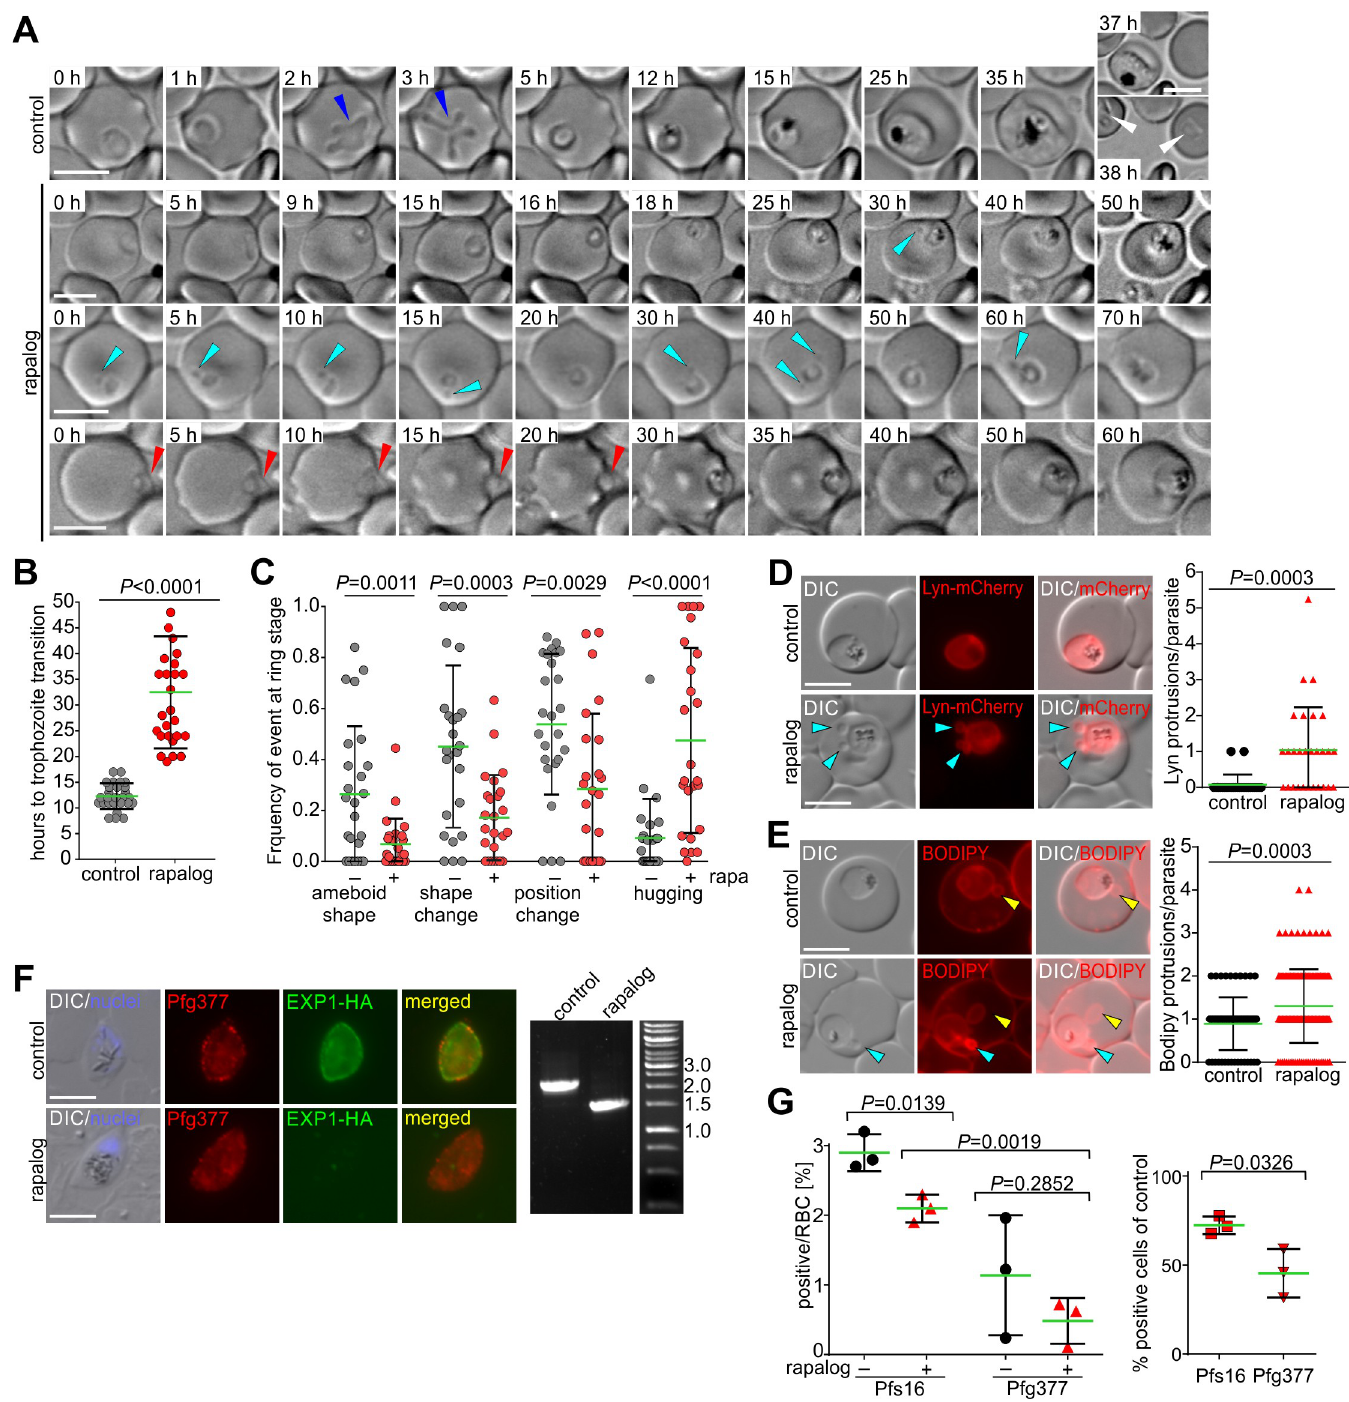
Fig 2. Morphological phenotypes of Δ EXP1 parasites. (A) Time-lapse imaging of cond Δ EXP1 parasites starting a cycle with (control) and without EXP1 (rapalog) imaged side by side. Single DIC z-sections of selected time points of typical phenotypes are shown: top row: slow development; mid row: failure to reach full trophozoite stage; bottom row: cell showing extensive hugging. Arrowheads: white, ring stages after reinvasion; blue, amoeboid ring; light blue, blebs; red, hugging. (B) Number of hours (after start of the time lapse experiment) to reach young trophozoite stage in n = 24 control and N = 27 Δ EXP1 parasites. (C) Frequency of the indicated events in individual ring stages observed by time lapse microscopy (presence or absence of event was scored every hour); n = 25 parasites each for Δ EXP1 and control. (D, E) Left, live cell images of control and Δ EXP1 (rapalog) parasites expressing Lyn-mCherry (PPM marker) (D) or labelled with Bodipy TR ceramide (BODIPY) (E). Light blue arrowheads, blebs; yellow arrowheads, TVN. Graphs: quantification of number of blebs per cell (controls N = 25, 73 for (D) and (E), respectively; Δ EXP1 (rapalog) n = 28